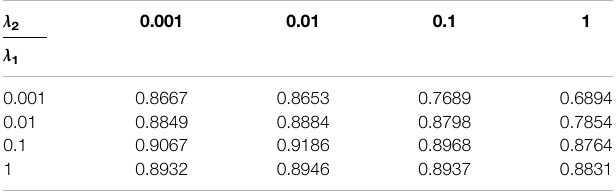
TABLE 1| Theareaunderthecurve(AUC)valueusingdifferent λ 1 and λ 2 valuesin the leave-one-out cross validation (LOOCV).